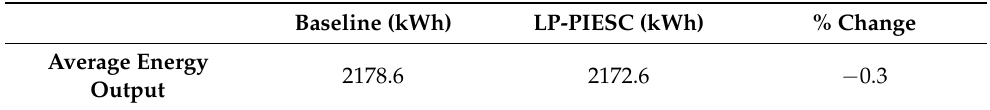
Table 7. Average energy capture for LP-PIESC compared to baseline Baseline (kWh) LP-PIESC (kWh) % Change 2178.6 2172.6 −